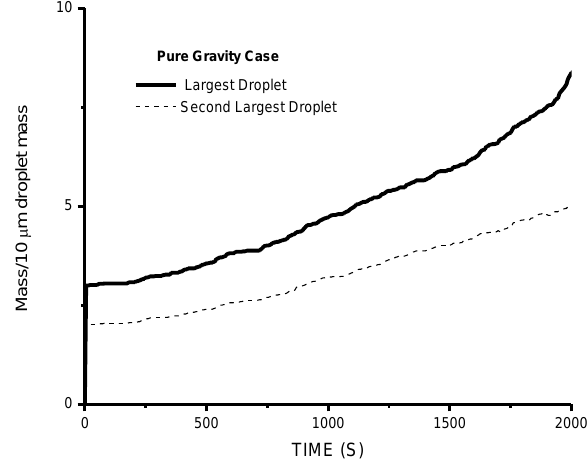
Fig. 6. Time evolution of the ensemble means over all the realizations for the largest (solid line) and second largest (dashed line) droplet masses (expressed in multiples of a 10µm droplet mass) for the turbulent case.